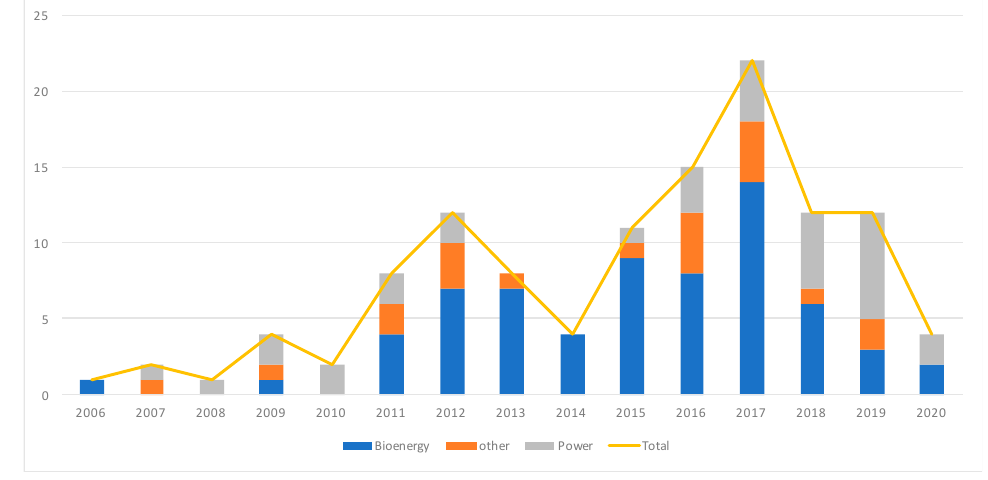
Figure 1. Numbers of articles by years and topics.